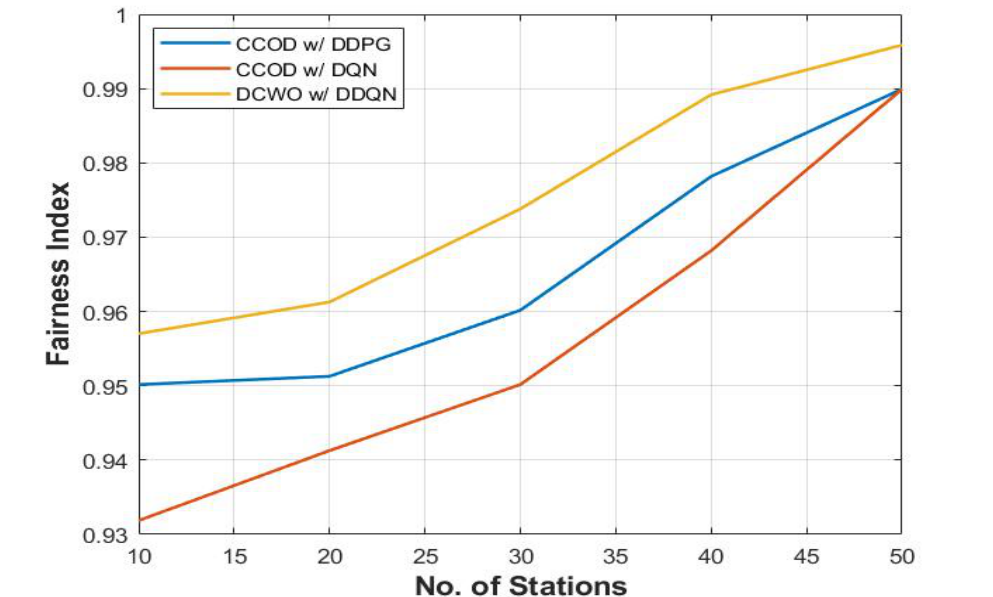
Figure 10. Network Fairness Index for Dynamic Scenario.